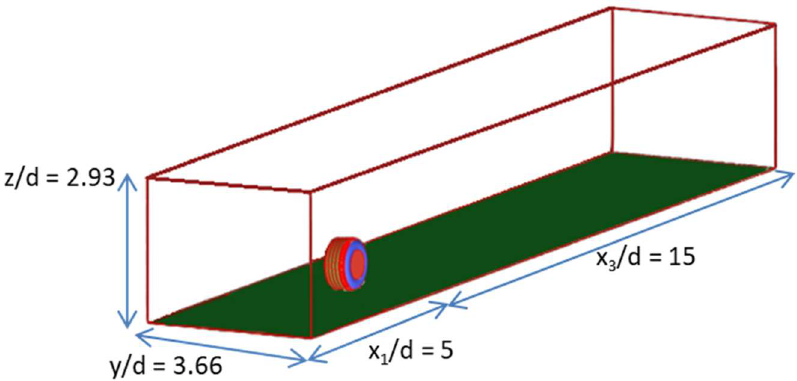
Figure 1. Flow domain of the isolated wheel.